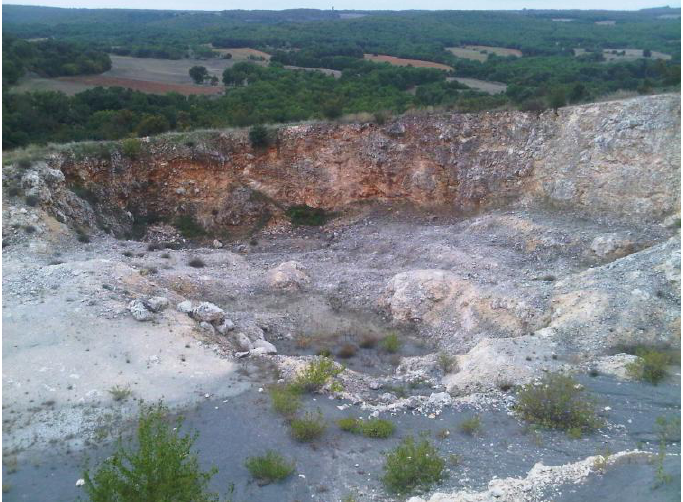
Figure 4. Area of the quarry with a prominent area of vegetation regeneration.